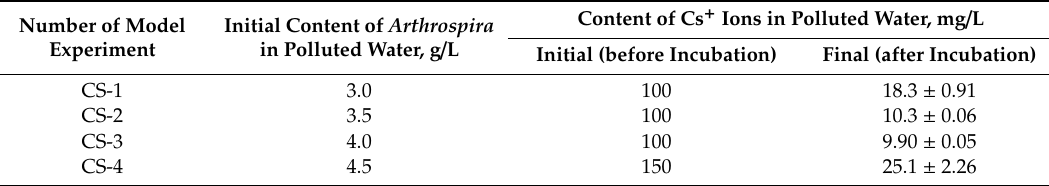
Table 3. Results of model experiments for cleaning water polluted with Cs + ions by using Arthrospira . Mean values (n = 3) and ± SD are